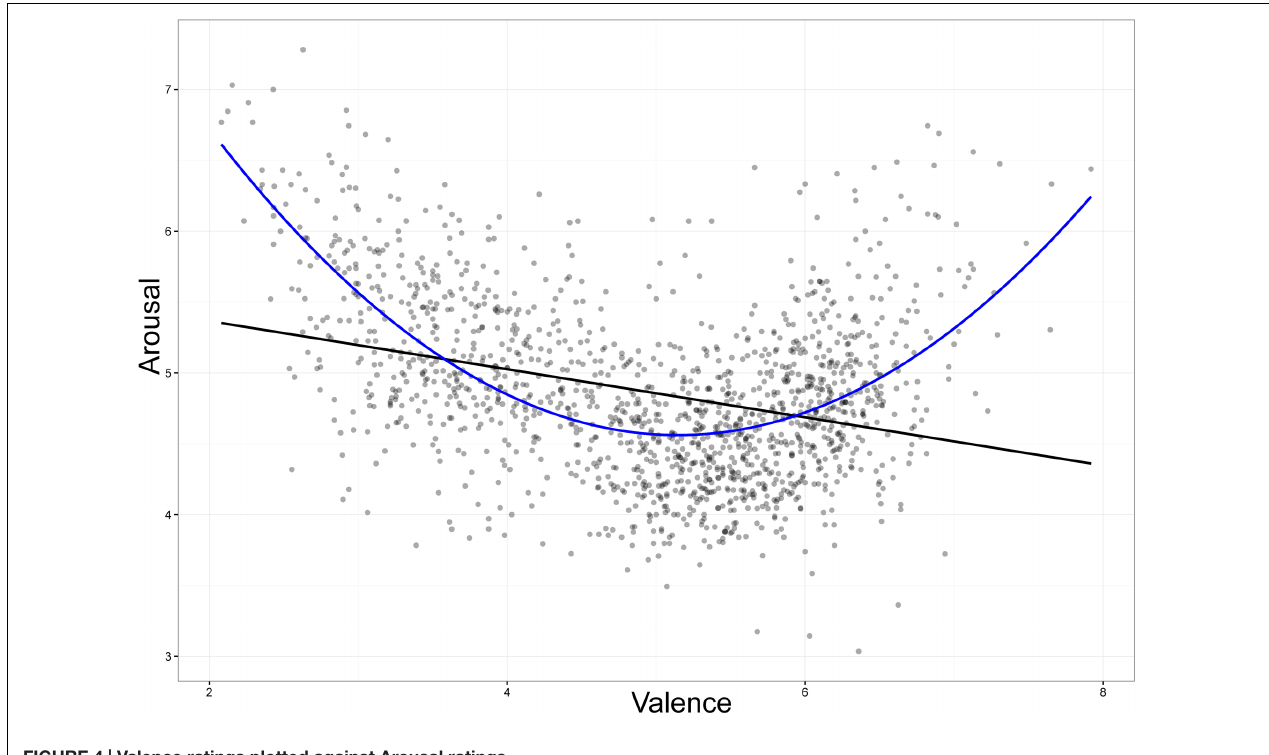
FIGURE 4 | Valence ratings plotted against Arousal ratings.